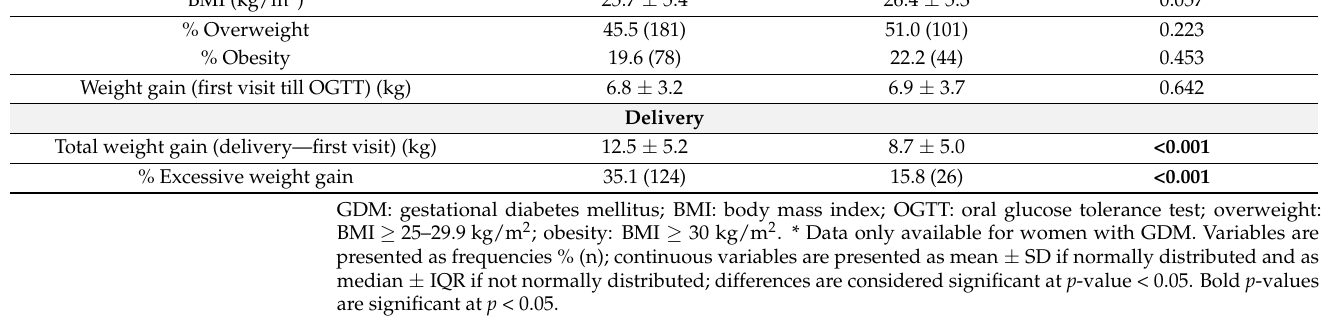
Table A2. Postpartum characteristics in women with GDM according to lower and upper tertiles of